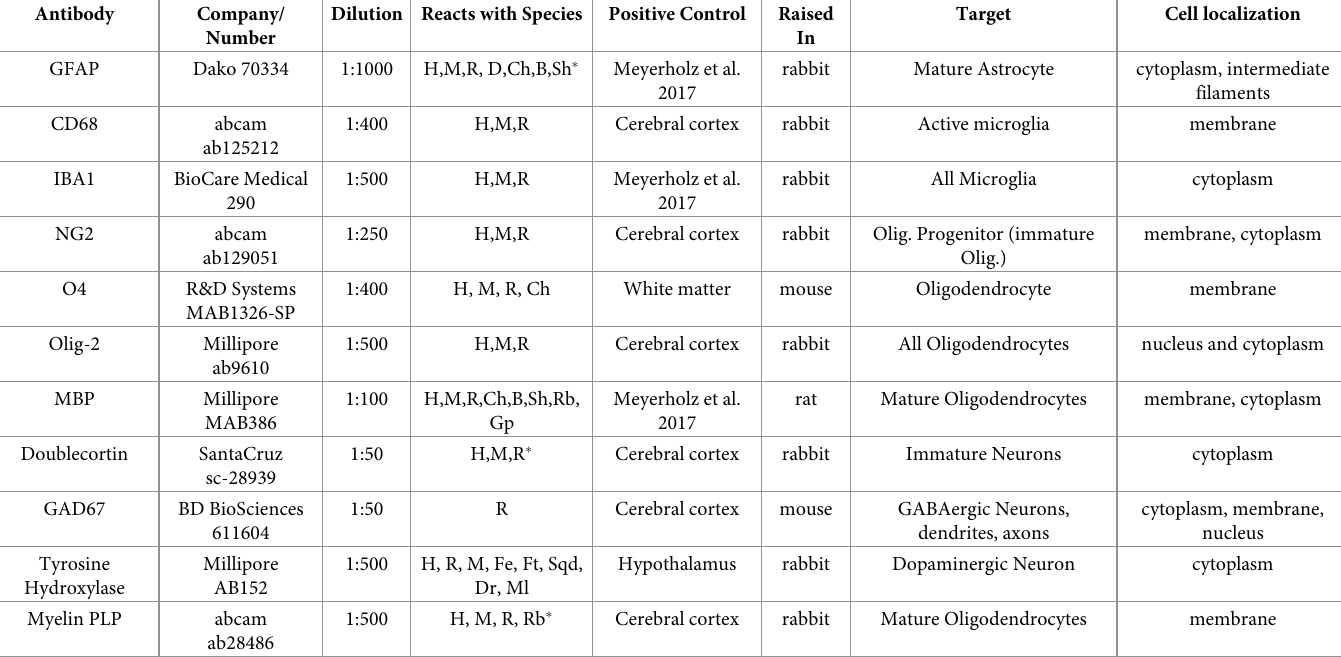
Table 1. Description, dilution and cellular localization of each antibody